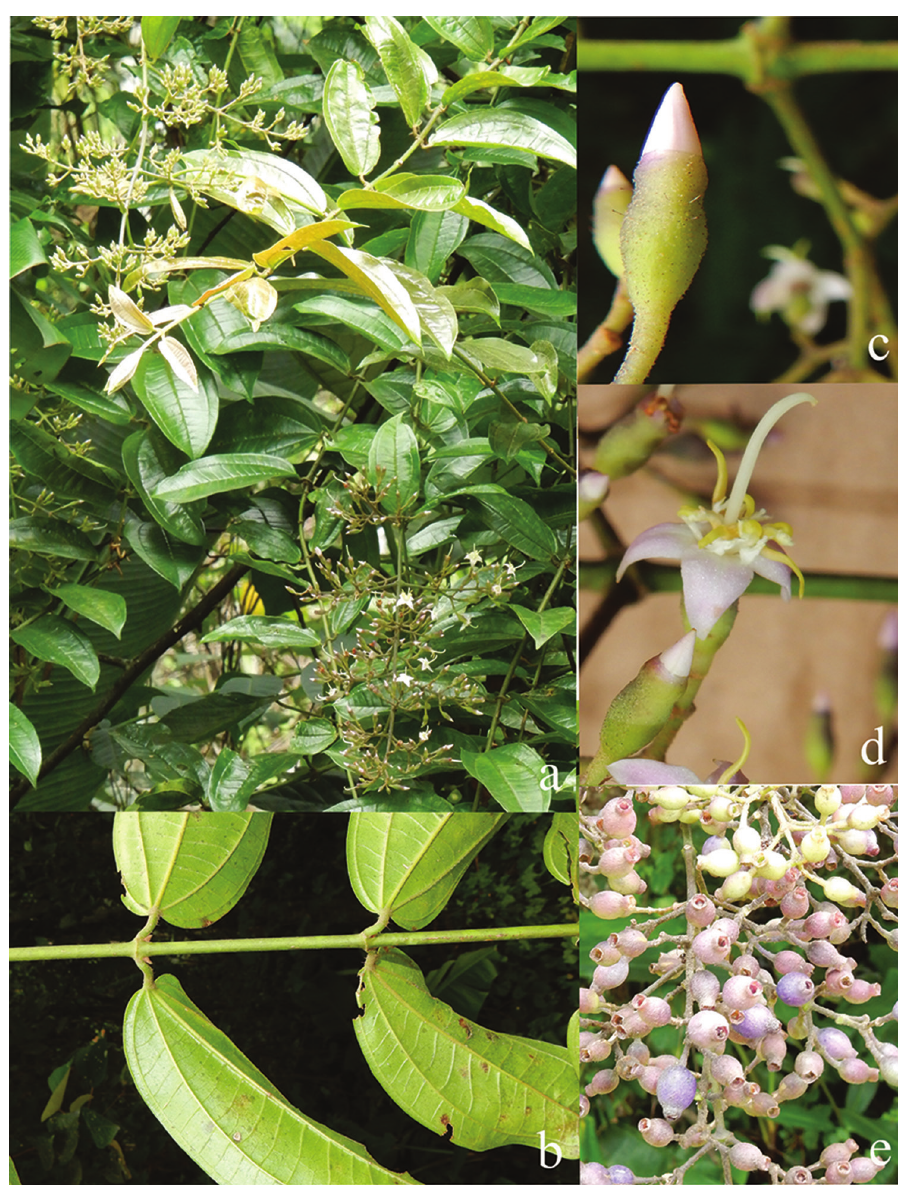
Figure 12. Dissochaeta divaricata a habit b branchlet c hypanthium d flower e fruits. Photographs by D. Penneys; voucher: Penneys 2472